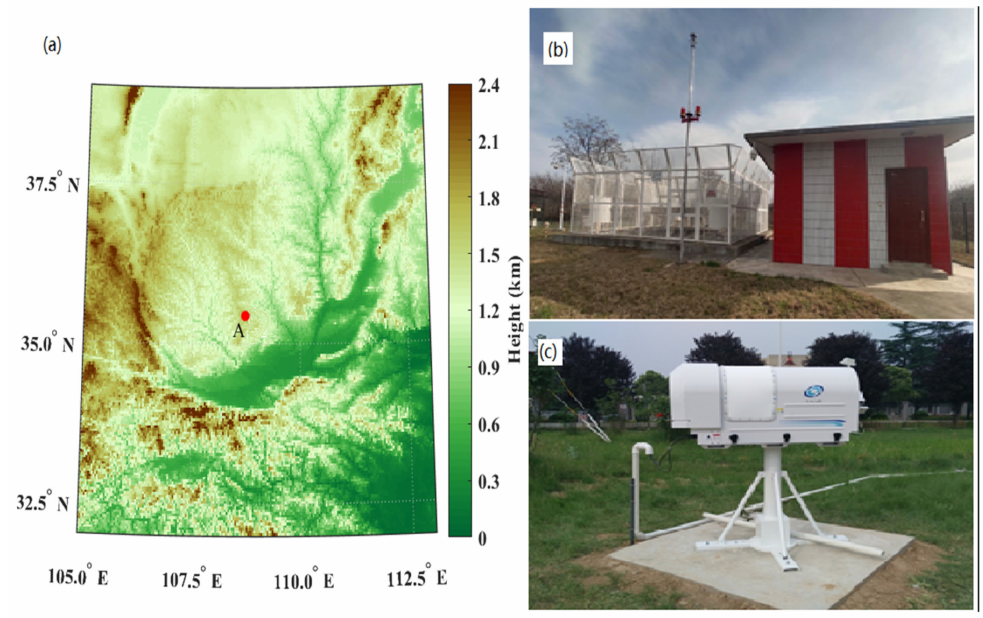
Figure 1. ( a ) Location map of Xianyang International Airport; ( b ) the CFL-03 wind profiling radar; ( c ) the microwave radiometer. Table 1. Parameters of CFL-03 boundary layer wind profiling